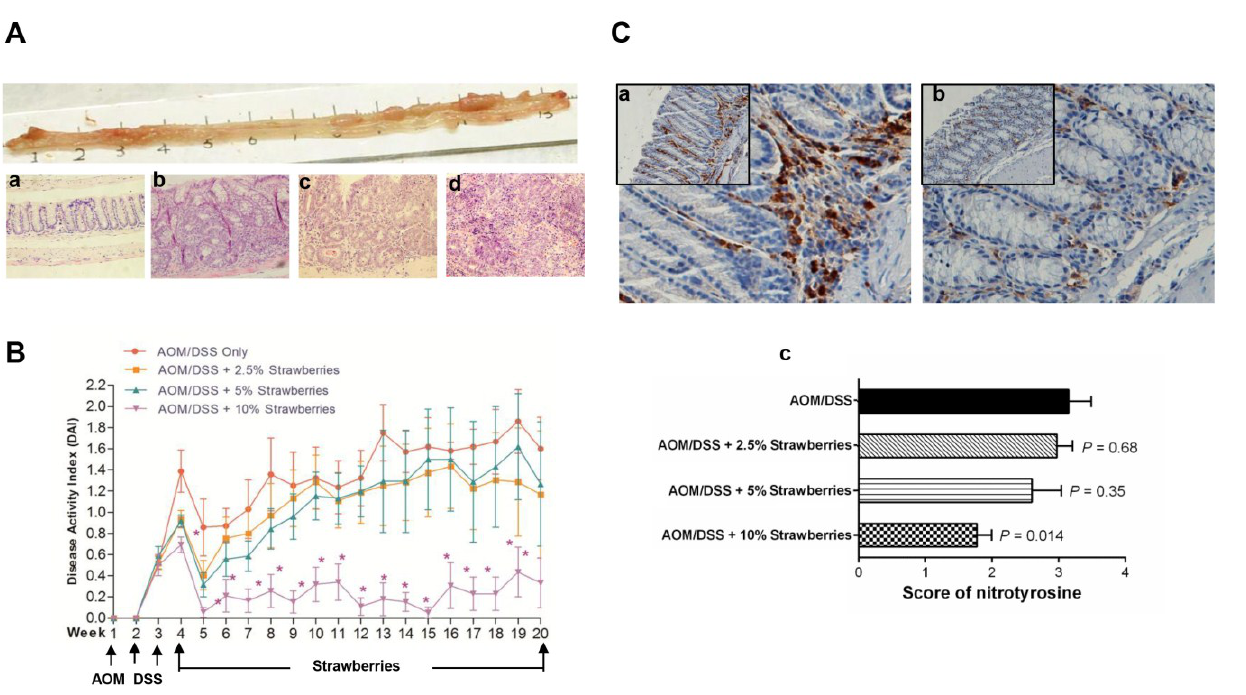
Figure 2. ( A ) upper panel, representative macroscopic appearance of mouse colon treated with azoxymethane (AOM)/dextran sodium sulfate (DSS). Lower panel, representative hematoxylin and eosin stained sections show different histopathology of mouse colon including normal (a), dysplasia (b), adenoma (c) and adenocarcinoma (d). Images are shown at 200× magnification; ( B ) disease activity index (DAI) of AOM/DSS-treated mice. Mice fed strawberries had lower DAI than those fed control diet; bars, ± SE. * p < 0.05; and ( C ) immunochemistry of nitrotyrosine. Stronger positive nitrotyrosine immunoreactivity infiltrated (b). Strawberries decreased scores of nitrotyrosine immunoreactivity (c). 3.5. Strawberries Decrease Phosphorylation of PI3K, Akt, ERK and